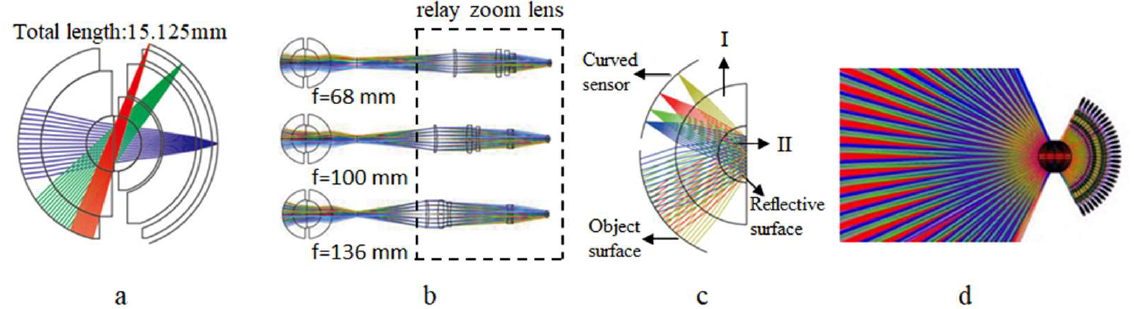
Figure 2. Monocentric lenses for different applications ( a ) miniaturized ultra-wide-angle surveillance lens, ( b ) wide-field infrared zoom lens, ( c ) reflective mobile phone monocentric lens, ( d ) ultra-low-altitude remote sensing monocentric lens.